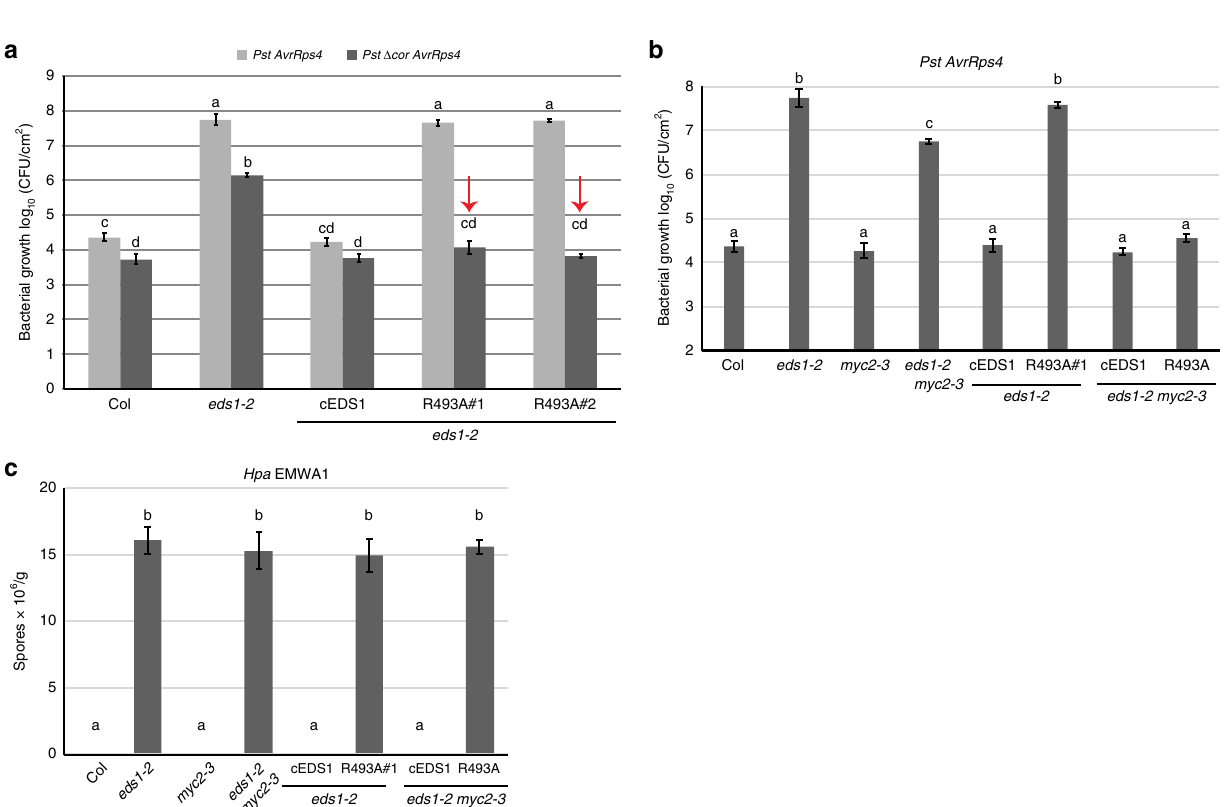
Fig. 3 EDS1 R493A fails to antagonise bacterial COR-stimulated MYC2 in TNL immunity. a Four-week-old Arabidopsis plants of the indicated genotypes were in fi ltrated with Pst AvrRps4 or Pst Δ Cor AvrRps4 (OD 600 – 0.0005). Bacterial titres were determined at 0 and 3 dpi. No signi fi cant difference was observed between lines and treatments at 0 dpi. Bars represent mean of four biological replicates± SE. Differences between genotypes were analysed using ANOVA (Tukey ’ s HSD, p -value < 0.005). Similar results were obtained in three independent experiments. b Four-week-old Arabidopsis plants of the indicated genotypes were in fi ltrated with Pst AvrRps4 (OD 600 – 0.0005). Bacterial titres were determined at 0 and 3 dpi. No signi fi cant differences were observed at 0 dpi. Bars represent mean of four biological replicates± SE. Differences between genotypes were analysed using ANOVA (Tukey ’ s HSD, p -value < 0.005). Similar results were obtained in three independent experiments. c The indicated genotypes were infected with Hpa EMWA1 and oomycete sporulation was quanti fi ed at 5 dpi. Data from three independent experiments were combined and differences between genotypes analysed using ANOVA (Tukey ’ s HSD, p <